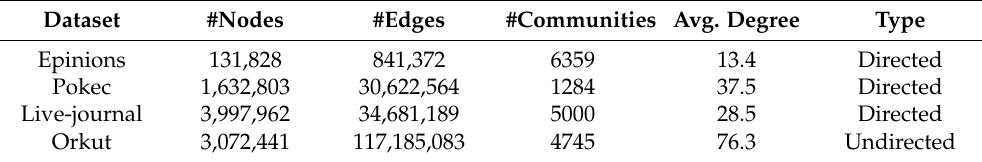
Table 2. Statistics of the